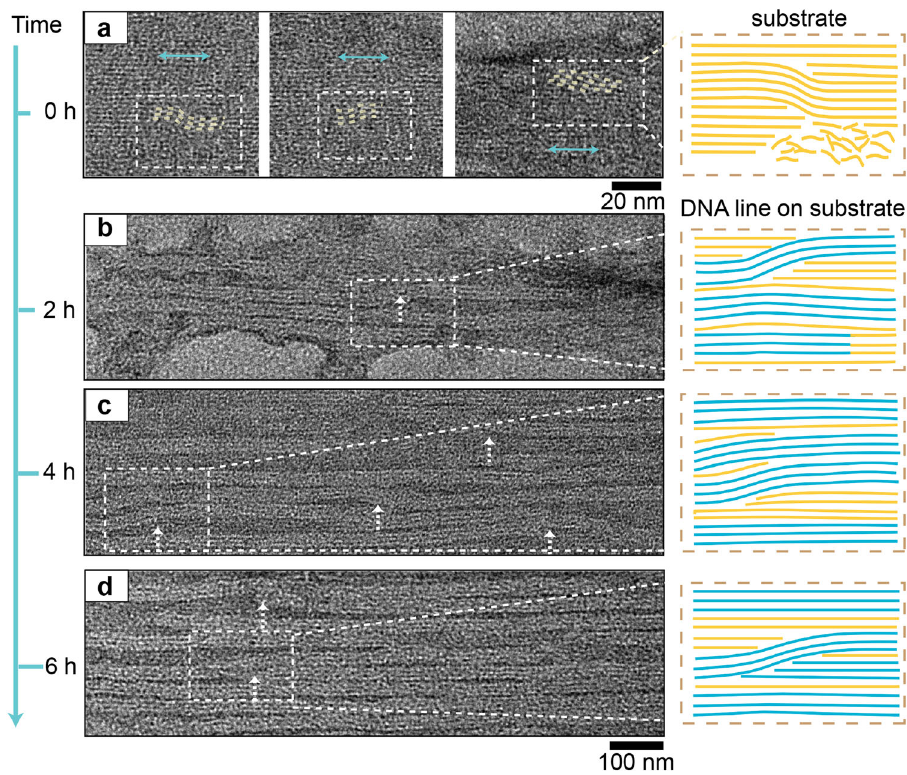
Fig. 4 Structural evolving for high-dimensional crystallographic defects. TEM images (left) and the line schematics along the x – z projection plane for the representative pattern morphologies (right) after substrate formation ( t = 0, a ) and line assembly ( t = 2 h, 4 h, and 6 h, b – d ). The scale bars are 20 nm in a and 100 nm in b – d . In a , white dashed boxes denote the typical pattern defect regions, and the line dislocations in the substrate are marked with yellow dashed lines. The cyan arrows indicate the helical directions of the correct DNA lattices. From b to d , the white arrows indicate typical line dislocations. The presence of typical line dislocations blocks the correct lattice extension of the neighboring DNA